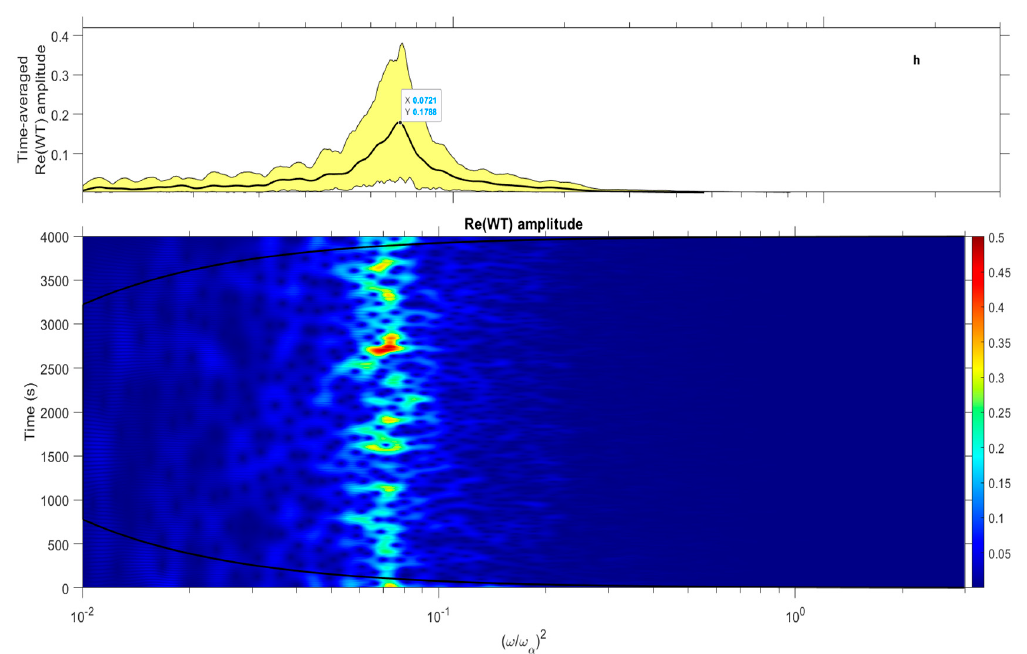
Figure 36. Time–frequency analysis ( ℎ , closed-loop, ν = 1 ).